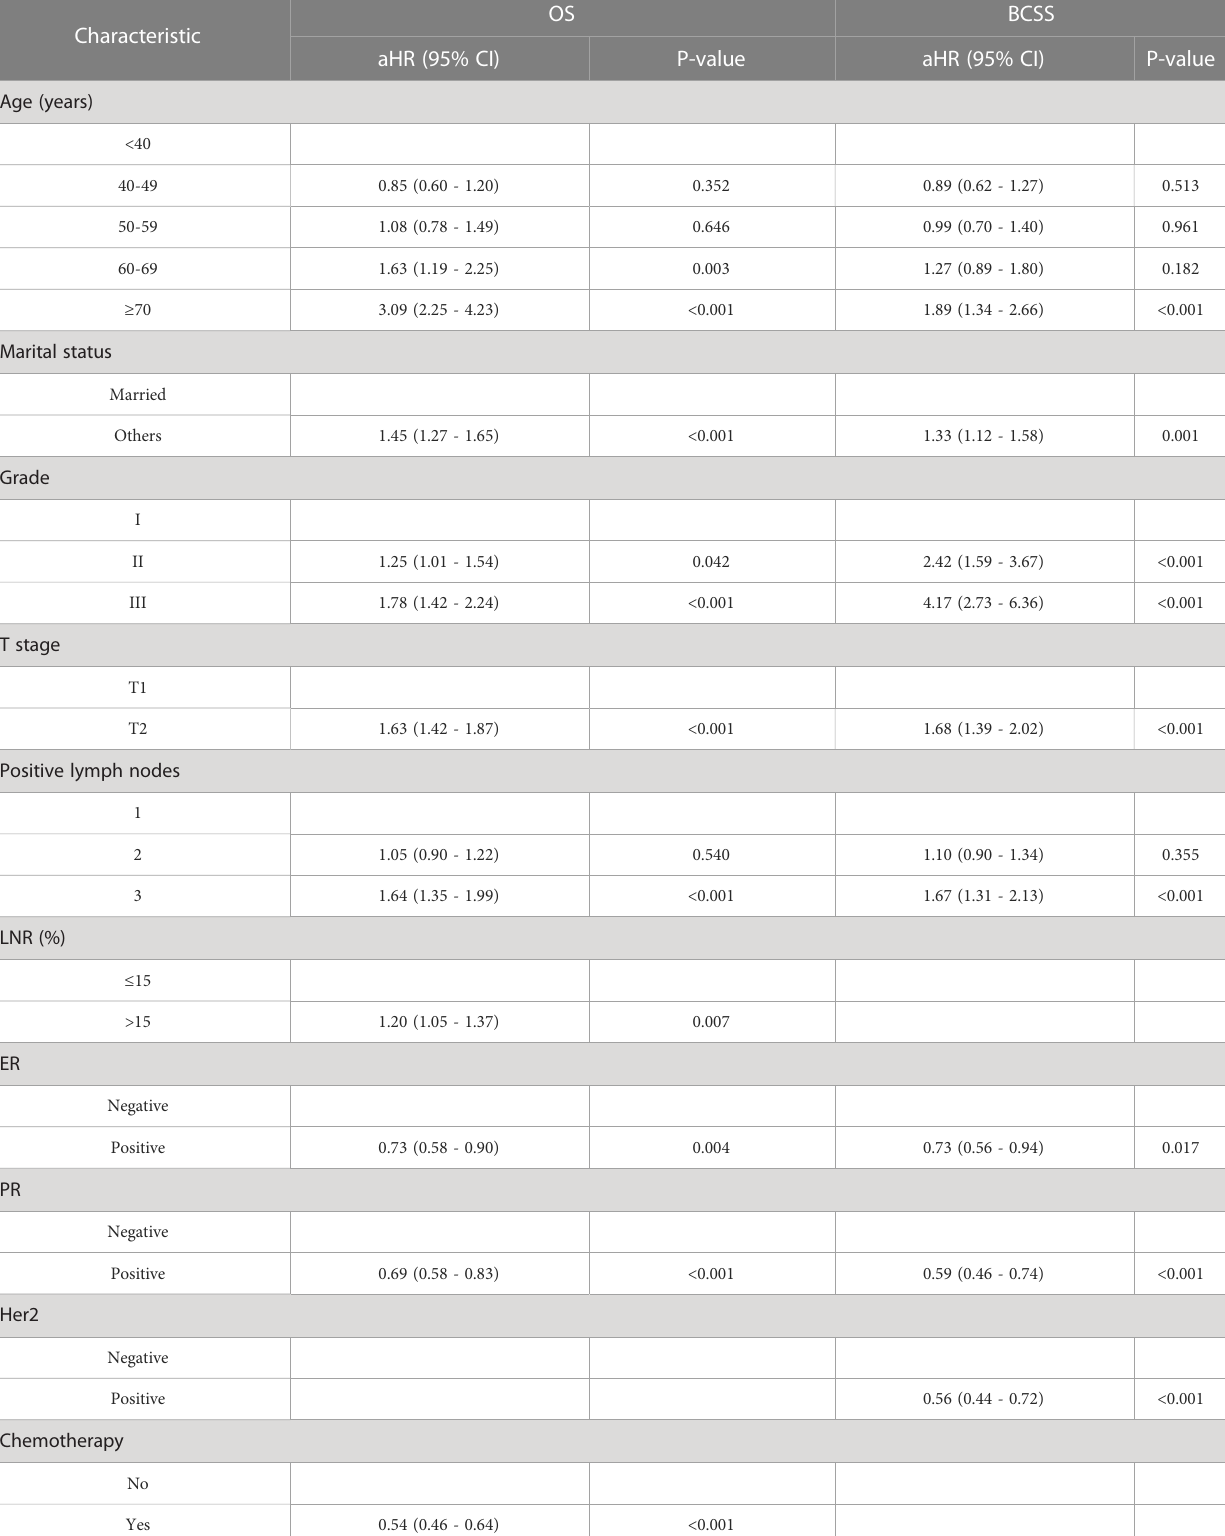
TABLE 2 Multivariate Cox analysis for OS and BCSS in the training cohort based on the results of LASSO regression.